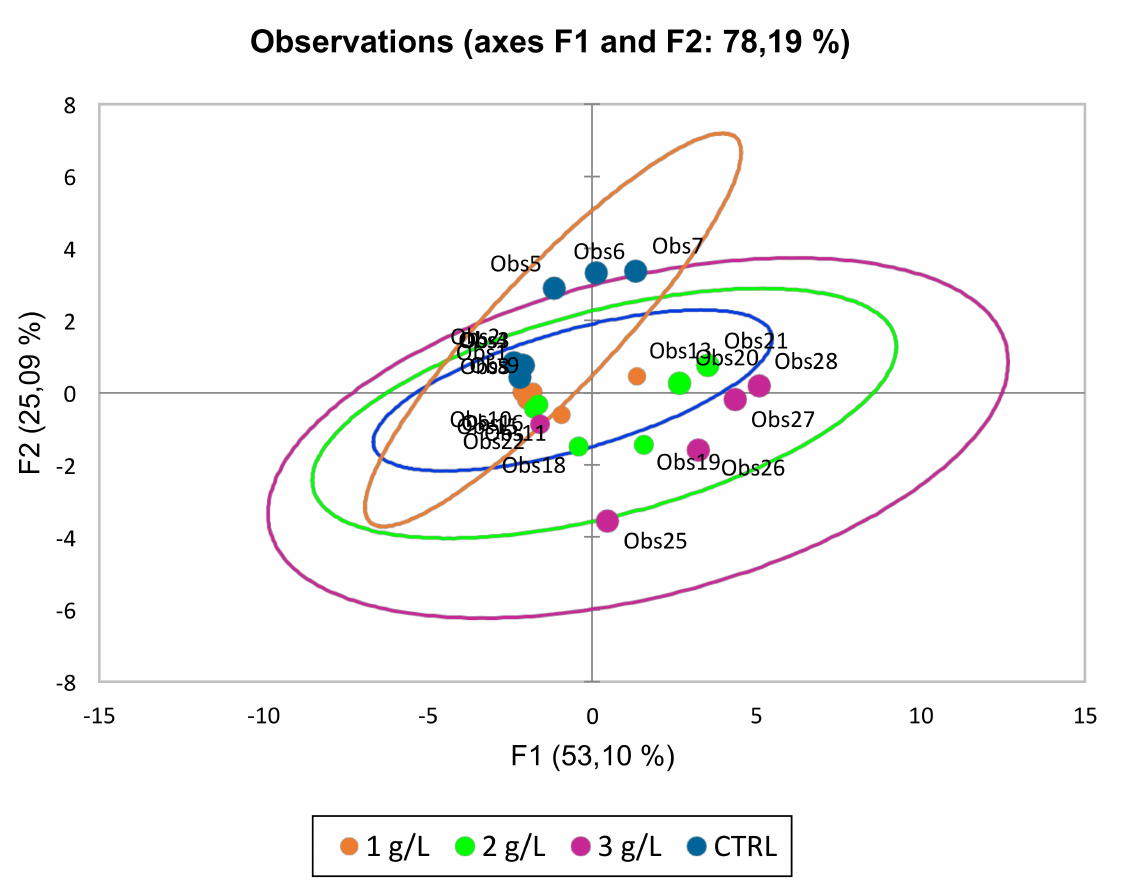
Figure 8. Principal component analysis (PCA): Distribution of treatments grouped according to di ff erent bicarbonate concentration. Control (orange color), 1 g L − 1 (blue color), 2 g L − 1 (green color), and 3 g L − 1 (pink